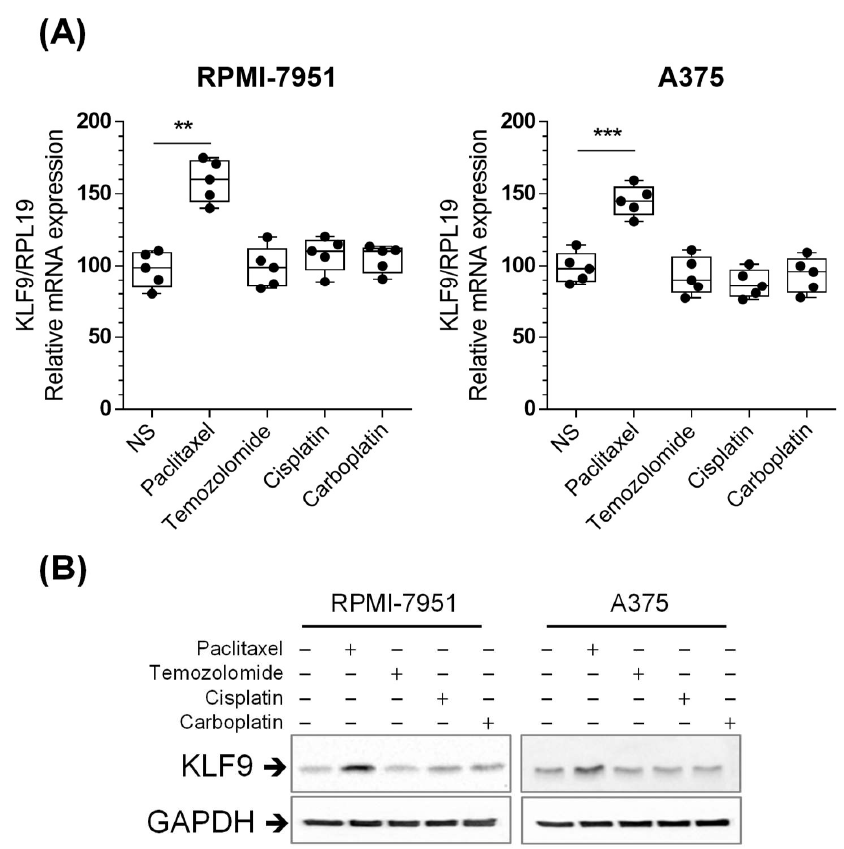
Figure 7. TMZ, CIS, or CARB did not change mRNA or protein levels of KLF9 in malignant melanoma-derived cell lines. RT-PCR ( A ) and Western blot analysis ( B ) illustrate the differential effects of four chemotherapeutic agents on KLF9 mRNA and protein levels in RPMI-7951 and A375 cells. Data ( n = 5), significant difference was determined using ANOVA with Tukey’s correction for multiple comparisons. ** p ≤ 0.01, *** p ≤ 0.001 vs. non-stimulated cells.